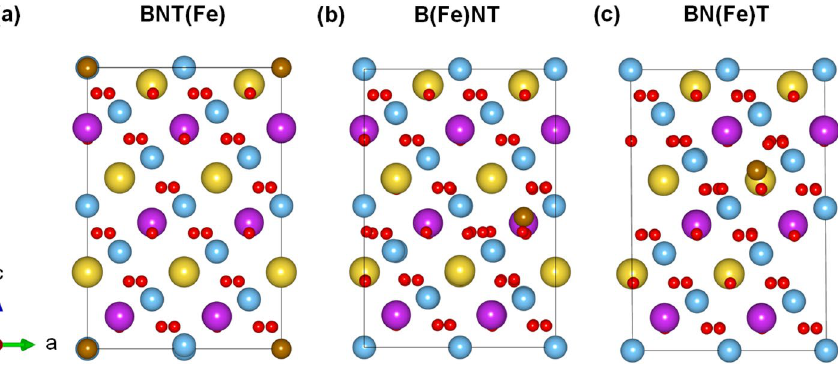
Figure 9. (a) Side views of the optimized atomic structure of the (a) Ti-site [BNT(Fe)], (b) Bi-site [B(Fe) NT], and (c) Na-site Fe [BN(Fe)T] substitution. The atomic symbols follow the same convention used in Fig. 8. Brown spheres are the Fe substitutional